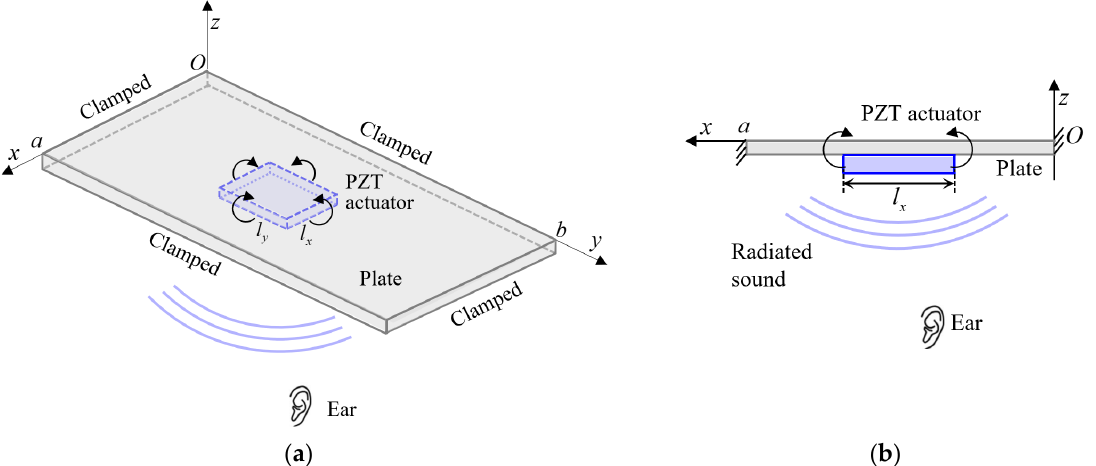
Figure 1. Radiated sound from the combination of a rectangular PZT actuator and a rectangular plate propagating to the ear location. ( a ) Three ‐ dimensional view. ( b ) Cross ‐ section at the middle of the combination in the y ‐ axis.